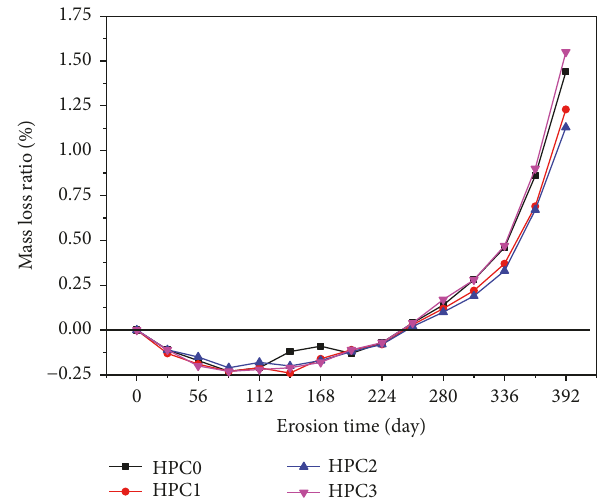
Figure 2: Porosity of HPCs at different erosion time. Figure 3: Mass loss ratio of HPCs before and after exposure to sulfate solution.